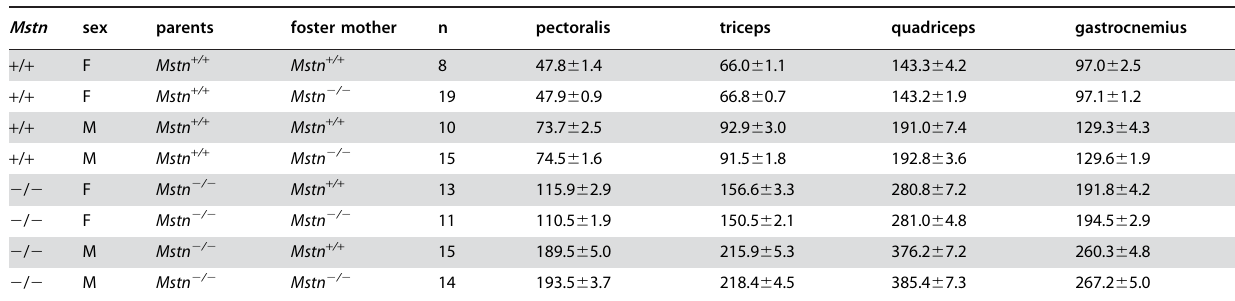
Table 4. Muscle weights (mg) following transfer of newborn mice to foster mothers. .. ... .... ... ... .... ... ... .... ... ... .... ... ... .... ... ... .... ... ... .... ... ... .... ... ... .... ... ... .... ... ... .... ... ... .... ... ... .... ... ... .... ... ...